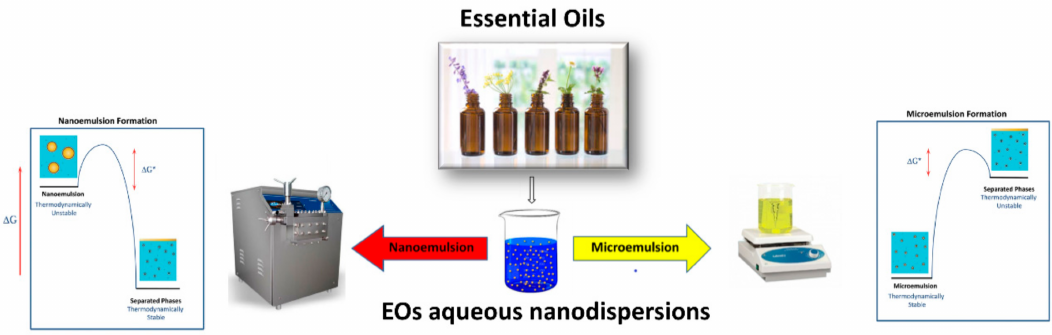
Figure 4. Nanoemulsions and microemulsions s for EOs delivery. Reproduced with permission from